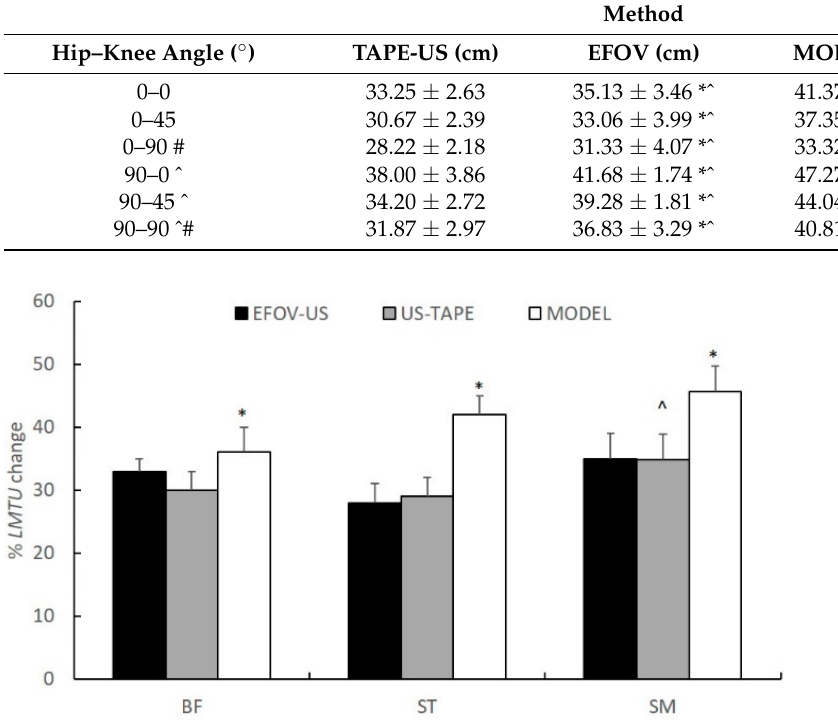
Table 4. Mean ( ± SD) group values of SM length (cm) at six combinations of hip and knee flexion angles, assessed using three different methods (* statistically significant different compared with the TAPE-US and EFOV-US method, ˆ values collapsed across methods and knee joint positions significantly different compared with a 0 ◦ hip flexion angle, # values collapsed across methods, and hip joint angles significantly different compared with a 0 ◦ knee flexion angle, p < 0.05). Method Hip–Knee Angle ( ◦ )